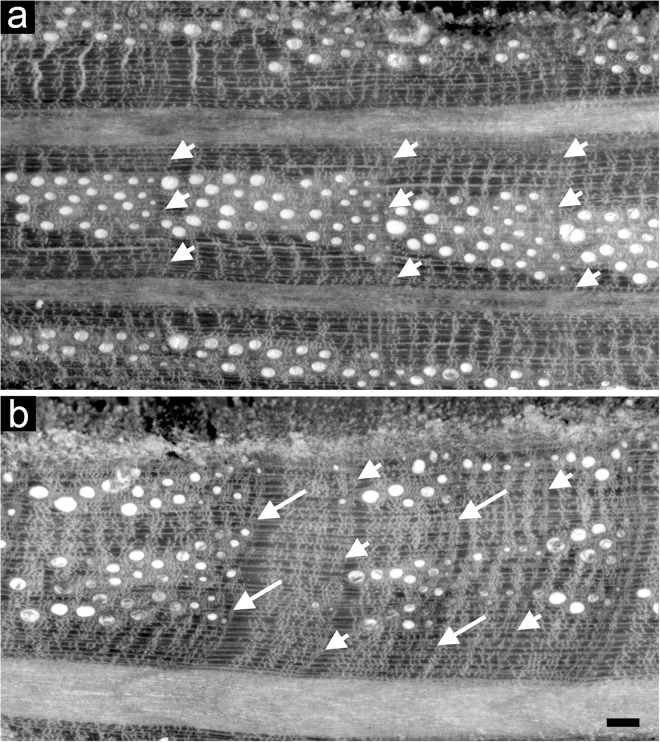
Light microscopy views of cross sections of tree rings of Quercus ilex without (a) and with IADFs (b). Arrowheads point the boundaries of tree rings; arrows point to the IADF. Bar: 100 μm.